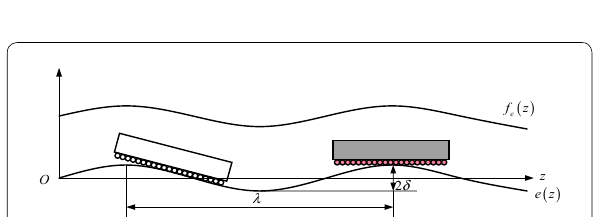
Figure 4 Bearing force caused by the sinusoidal straightness error in the rolling guideway